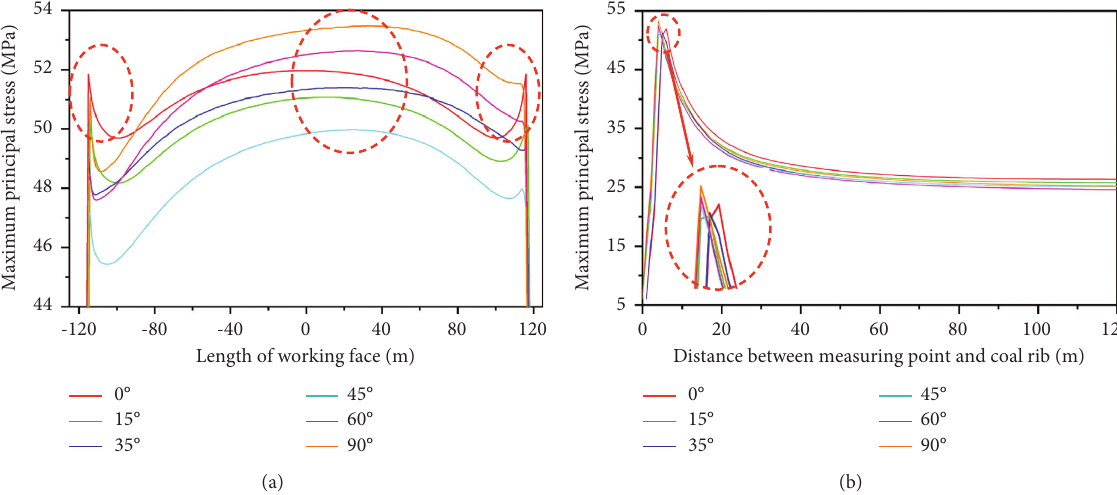
Figure 8: Maximum principal stress distribution of working face under different advancing direction and minimum principal stress angle. (a) The direction of length. (b) The direction of advancing.